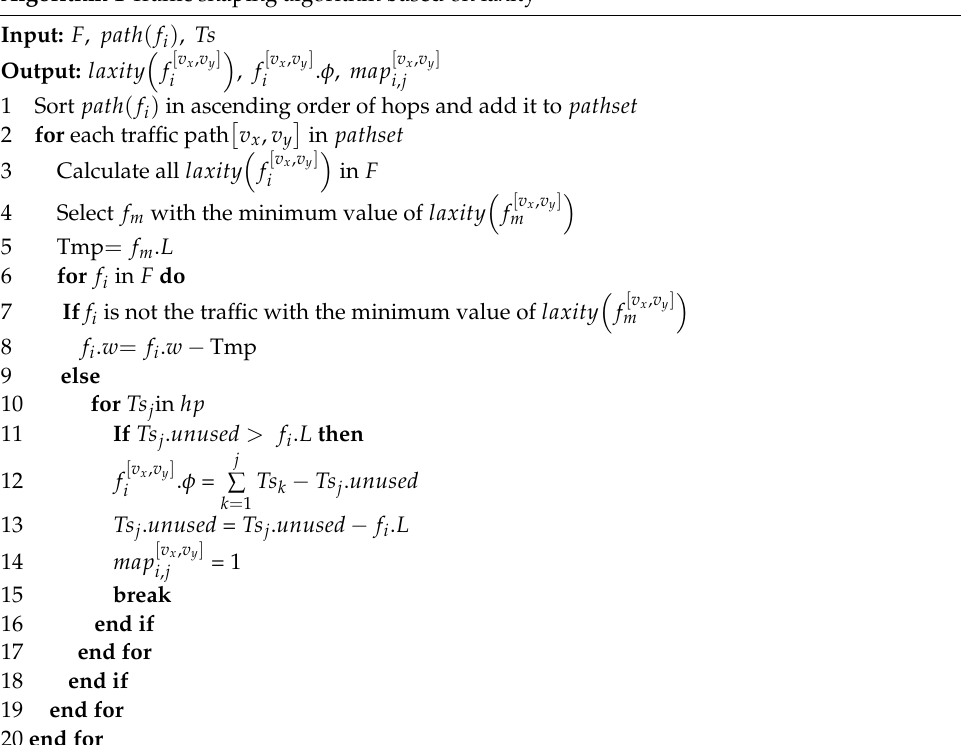
Algorithm 1 Traffic shaping algorithm based on